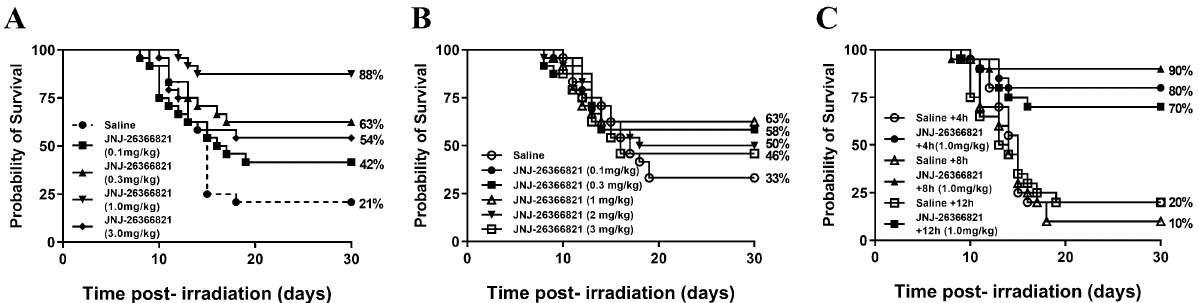
Figure 2. Time and dose optimization of JNJ-26366821 administration. ( A ) Optimization of JNJ-26366821 dose to improve survival of lethally irradiated CD2F1 mice when administered SC 4 h after 9.75 Gy TBI (n = 24/ group). Survival curves shown here are saline as the vehicle ( ● ) and JNJ-26366821 at doses of 0.1 mg/kg ( ■ ), 0.3 mg/kg ( ▲ ), 1.0 mg/kg ( ▼ ), and 3.0 mg/kg ( ♦ ), Percent survival on day 30 post-TBI is shown at the end of each curve. Kaplan–Meier survival curves were plotted using GraphPad software; n = 24 mice per group and trend in survival is compared between vehicle and drug-treated groups (Log-rank test p = 0.0001–0.2515). ( B ) Optimization of JNJ-26366821 dose to improve survival of lethally irradiated CD2F1 mice when administered SC 24 h after 9.35 Gy TBI (n = 24/group). Survival curves shown here are saline as the vehicle ( ○ ) and JNJ- 26366821 doses 0.1 mg/kg ( ● ), 0.3 mg/kg ( ■ ), 1.0 mg/kg (Δ), 2.0 mg/kg ( ▼ ) and 3.0 mg/kg ( □ ). Percent survival on day 30 post-TBI is shown at the end of each curve. Kaplan–Meier survival curves were plotted using GraphPad software; n = 24 mice per group and trend in survival is compared between vehicle and drug-treated groups. ( C ) Effect of TPOm administration SC at 4, 8 and 12 h post-TBI (9.75 Gy, n = 24/group) in CD2F1 mice. Survival curves shown here are saline as the vehicle at 4 h ( ○ ), 8 h (Δ), 12 h ( □ ) and JNJ-26366821 at 4 h ( ● ), 8 h ( ▲ ) and 12 h ( ■ ) post-TBI. Percent survival values on day 30 post-TBI are shown at the end of each curve. Kaplan–Meier survival curves were plotted using GraphPad software; n = 20 mice per group and trend in survival is compared between vehicle and drug-treated groups (Log-rank test p = 0.0001–0.0019). Figures were plotted using GraphPad Prism 9 software V9.0.2; www. graph pad. com.